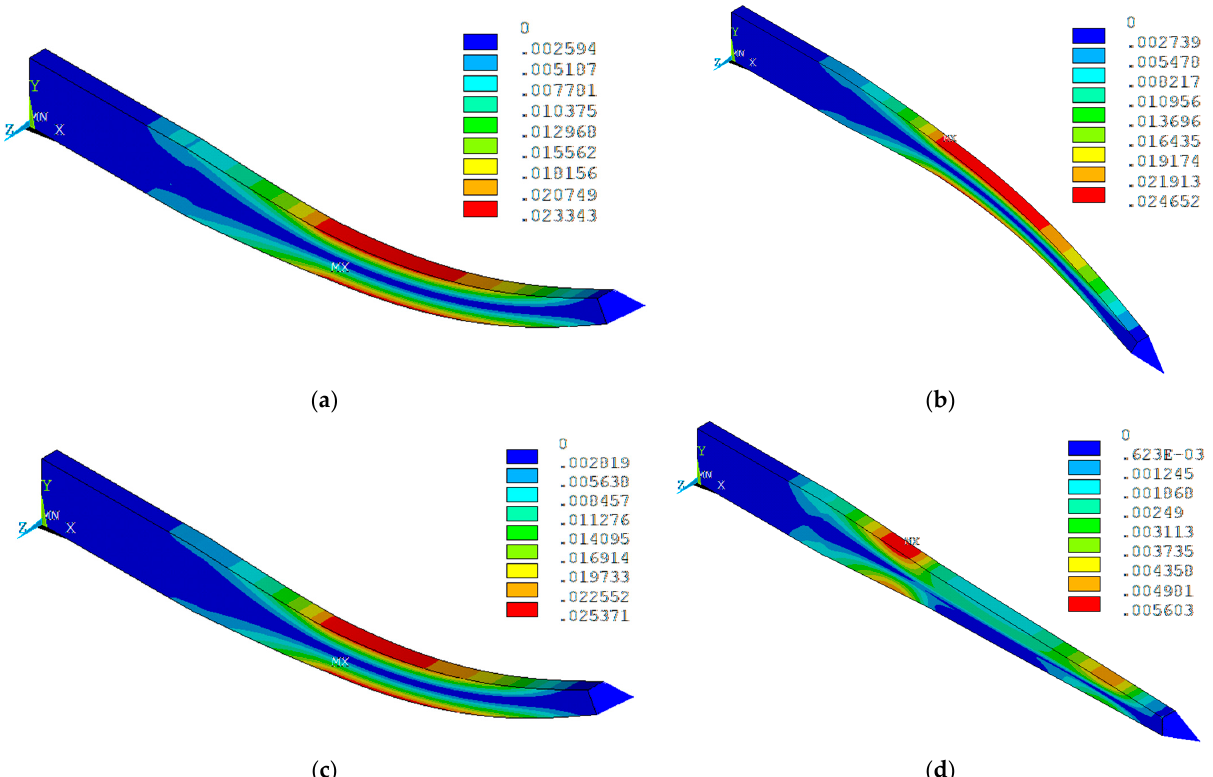
Figure 13. Analysis results of equivalent plastic strain distributions and deformation shapes of steel damper, SD2 during ±30 mm stroke: ( a ) After 1/4 cycle; ( b ) after 1(3/4) cycles; ( c ) after 3(1/4); ( d ) after 5 cycles.